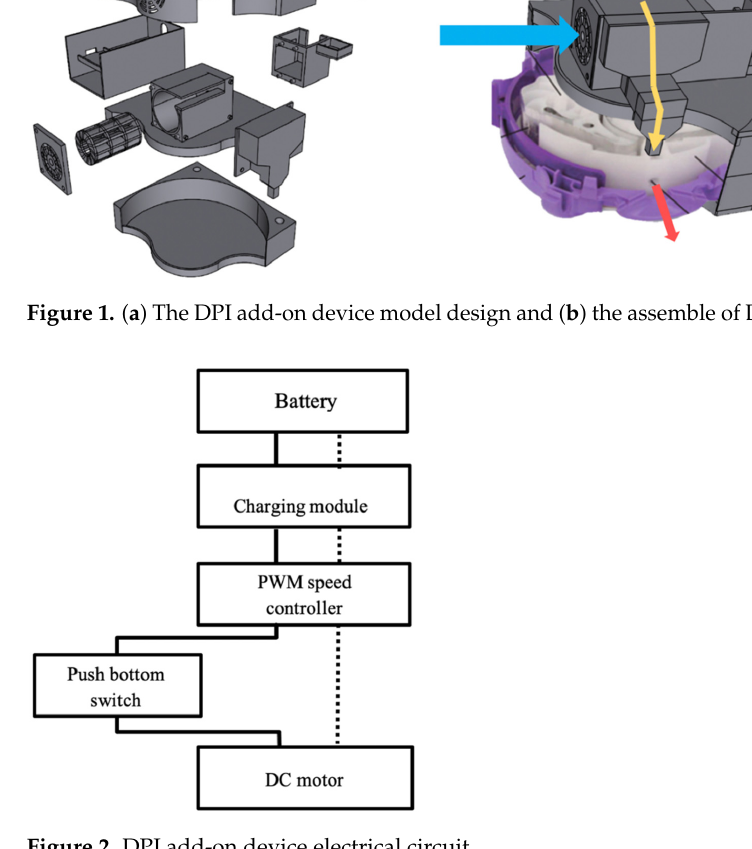
Figure 2. DPI add-on device electrical circuit.